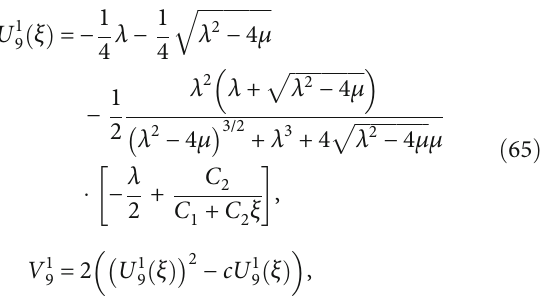
ffiffiffiffiffiffiffiffiffiffiffiffiffiffiffi p(cid:4)